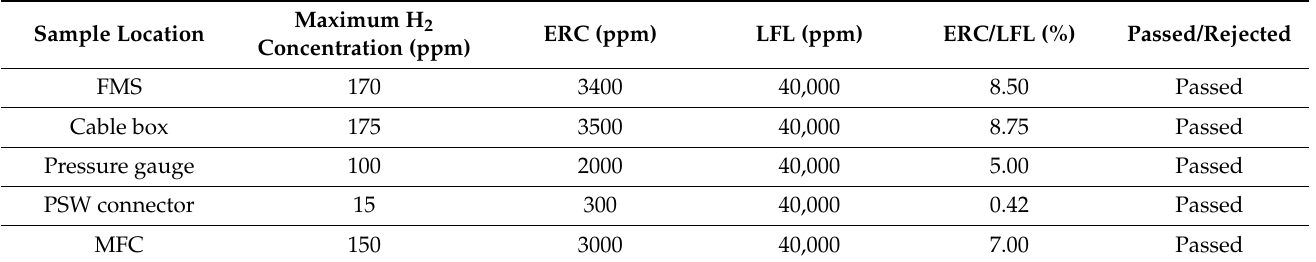
Table 5. Tracer gas test